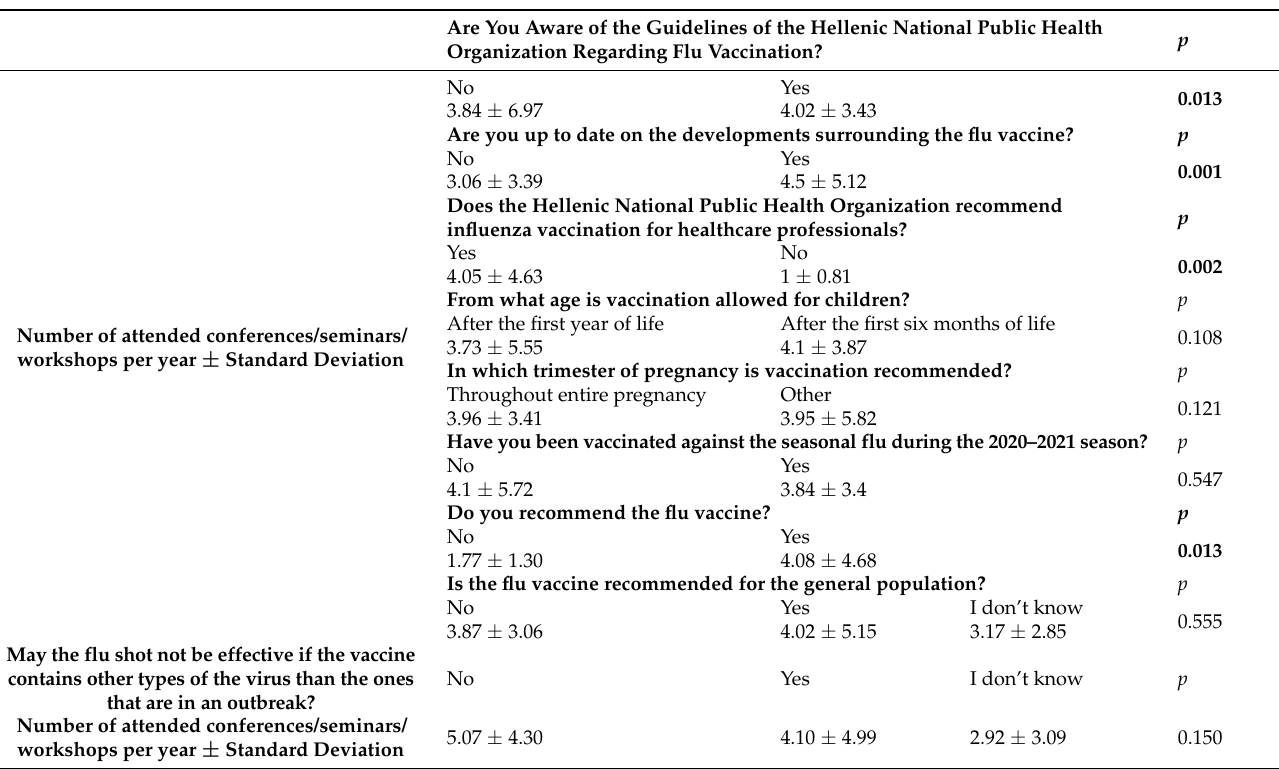
Table 6. Associations between the number of attended conferences/seminars/workshops per year and the knowledge about the flu vaccine.